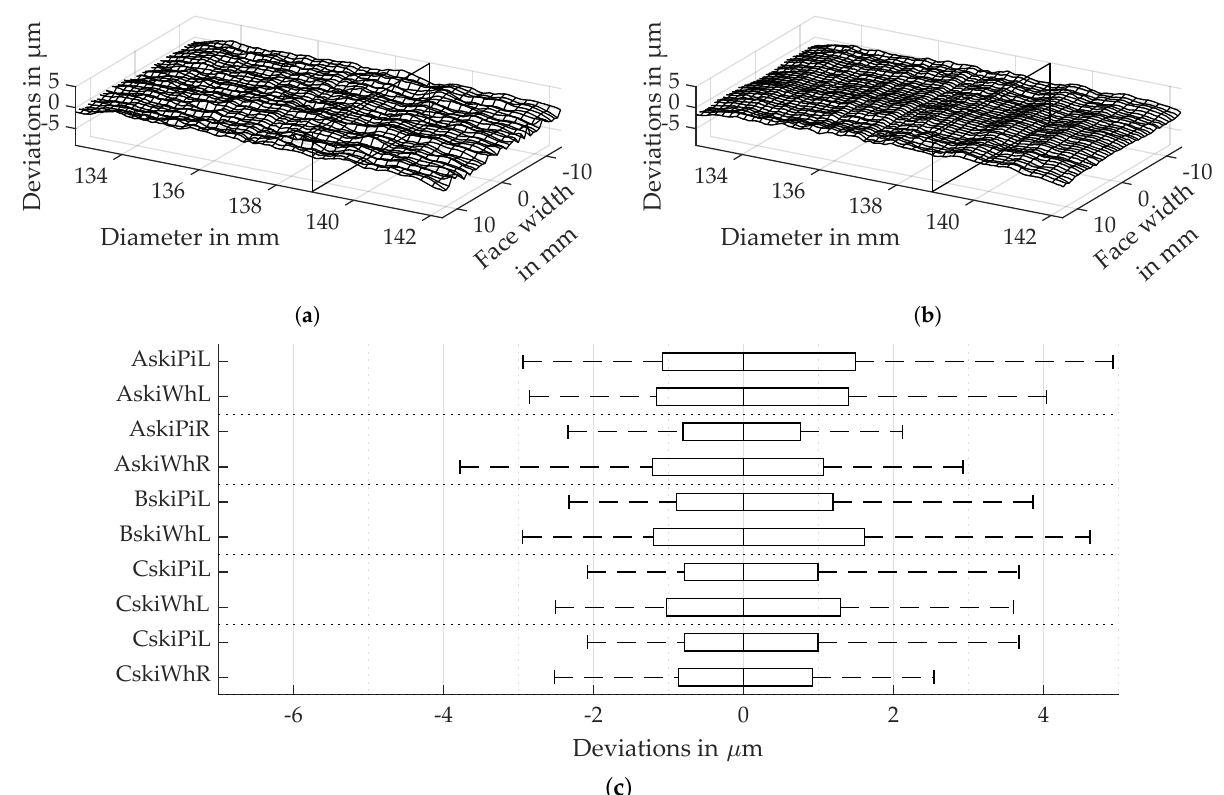
Figure 12. Deviations for gear skiving. ( a ) Flank of gear AskiPiR at tooth nr. 11. ( b ) Median of all teeth of gear AskiPiR. ( c ) Box plot of the deviations in the gear